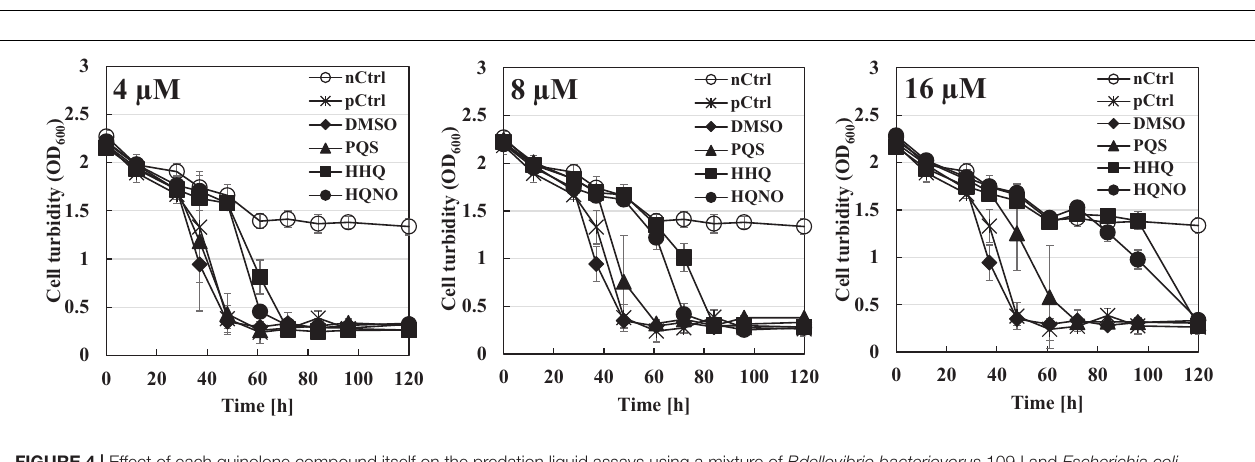
Frontiers in Microbiology |